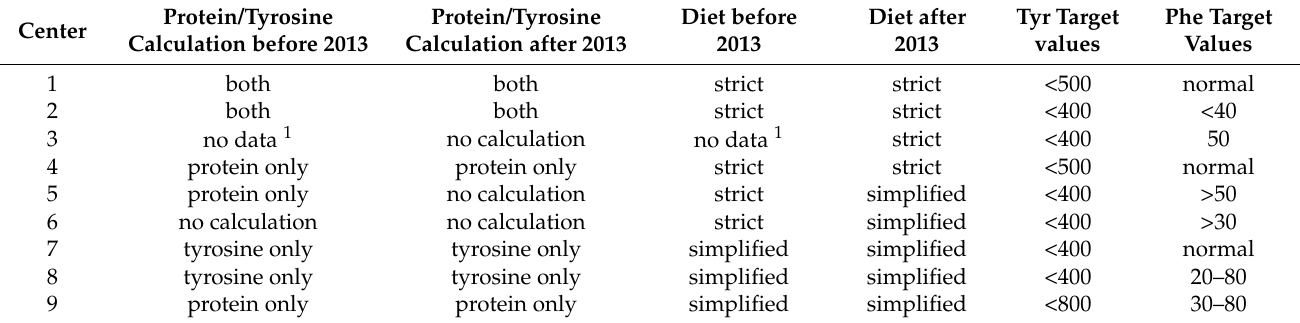
Table 2. Dietary recommendations at single centers: Calculation of protein and tyrosine in meals and diet regarding strict or simplified food selection are shown for the 2010–2013 and 2016–2019 periods. The target values for tyrosine and phenylalanine blood concentrations are